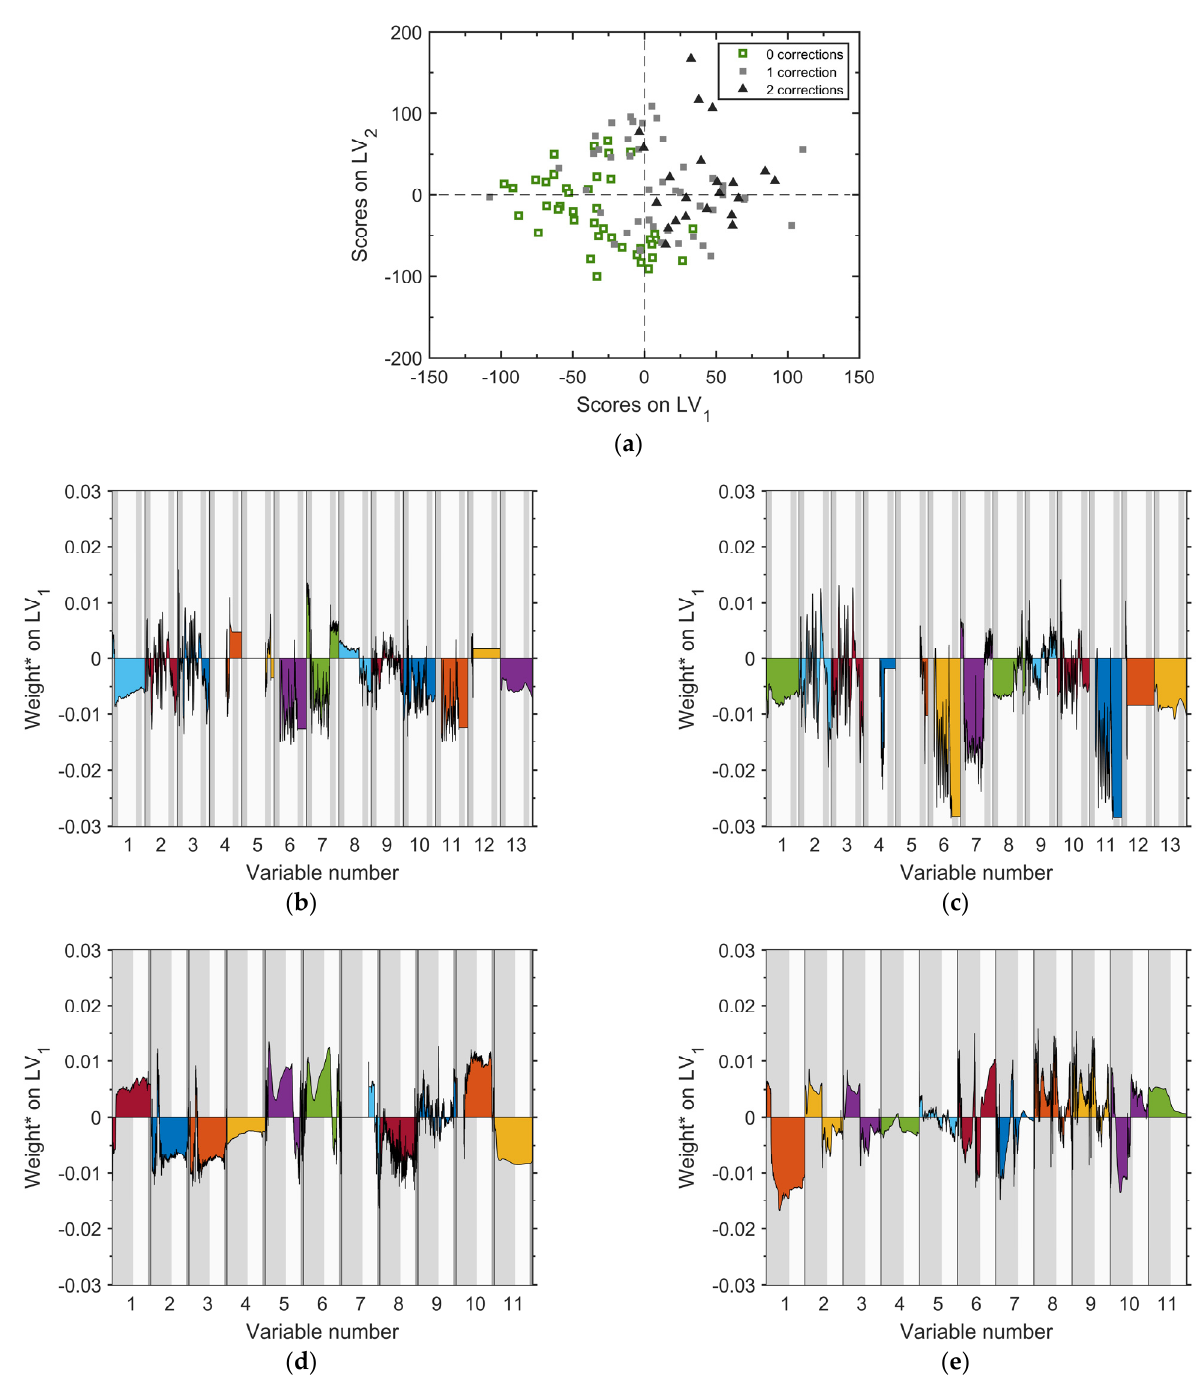
Figure 10. Two-component multiblock PLS-DA model for R201, R202 and R203. ( a ) Scores plot (each marker represents a charge to a unit, and the different shapes of the markers denote a different number of corrections eventually required); ( b – e ) time trajectories of the weights for the first latent variable for each process variable in R201 (Step A), R201 (Step B), R202, and R203, respectively (the variable numbering is reported in the Appendix A).